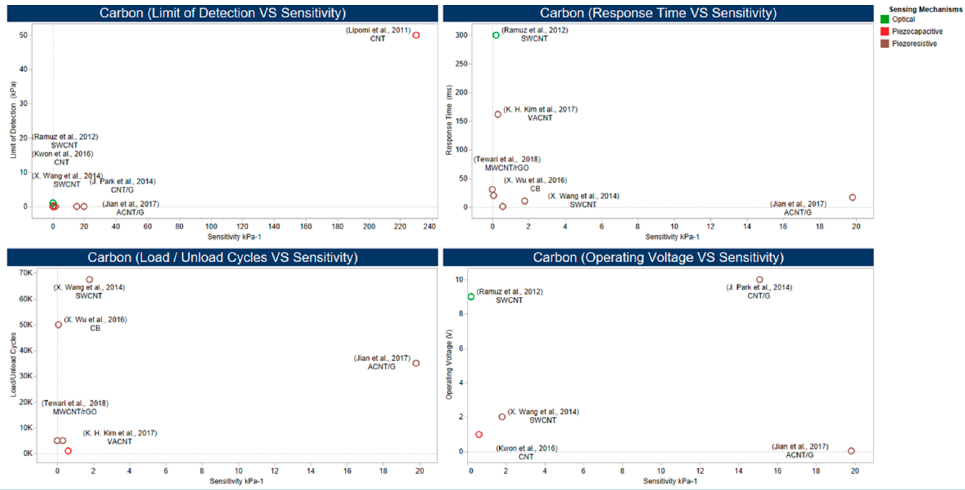
Figure 10. Effect of CNTs alignment on enhancing sensor performance.